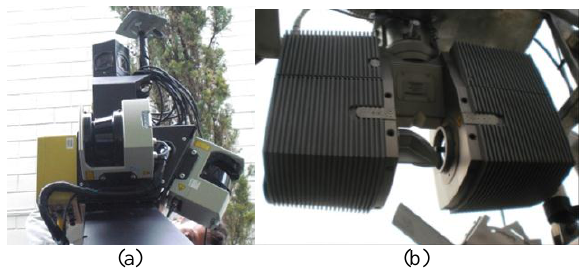
Figure 2. a) Laser SICK LMS 291 mounted on the IP-S2 system supplied by TOPCON. b) FARO PHOTON 120 mounted on ROAD-SCANNER